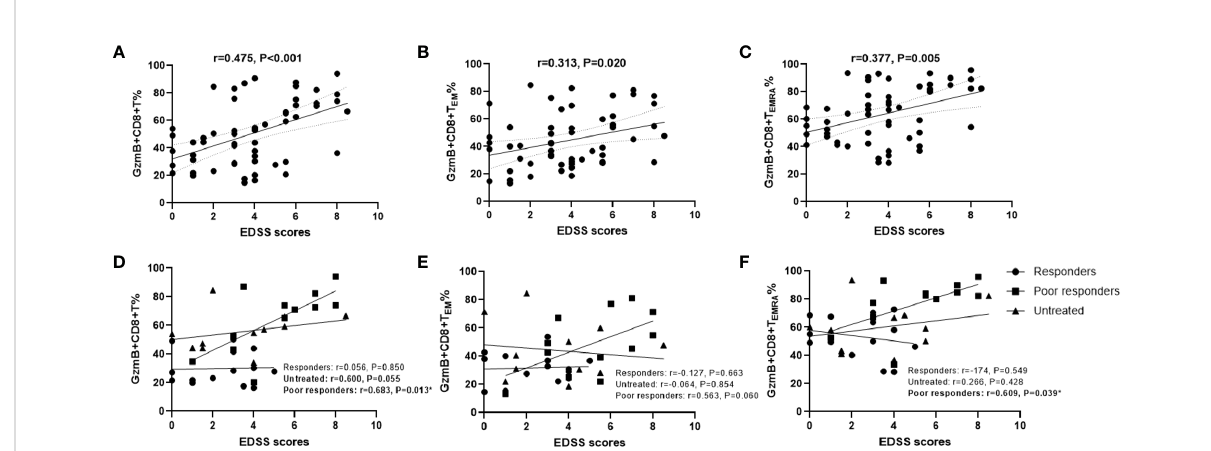
FIGURE 3 High proportions of GzmB-expressing CD8+ T cells are associated with disability in patients with NMOSD. (A – C) Correlation between Expanded Disability Status Scale (EDSS) scores and the percentages of GzmB+CD8+ T cells (A) , GzmB+CD8+ T EM cells (B) , and GzmB+CD8+ T EMRA cells (C) (Spearman correlation analysis). (D – F) Correlation analysis between EDSS scores and GzmB-expressing CD8+ T cell subpopulations according to the different immunotherapies and response, including responders group (n=14), untreated group (n=12), and poor responders (n=12) (Spearman correlation analysis). GzmB: granzyme (B) ns (not signi fi cant) by Mann – Whitney U-test. * indicates statistical signi fi cance